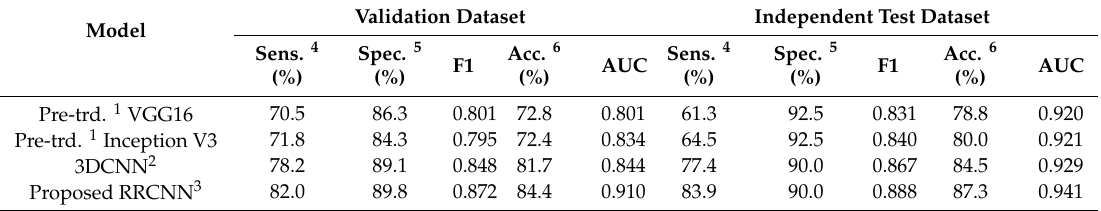
Table 2. Comparison of model performances between various deep learning algorithms for classifying patients with high di ff usion-weighted magnetic resonance imaging-Alberta Stroke Program